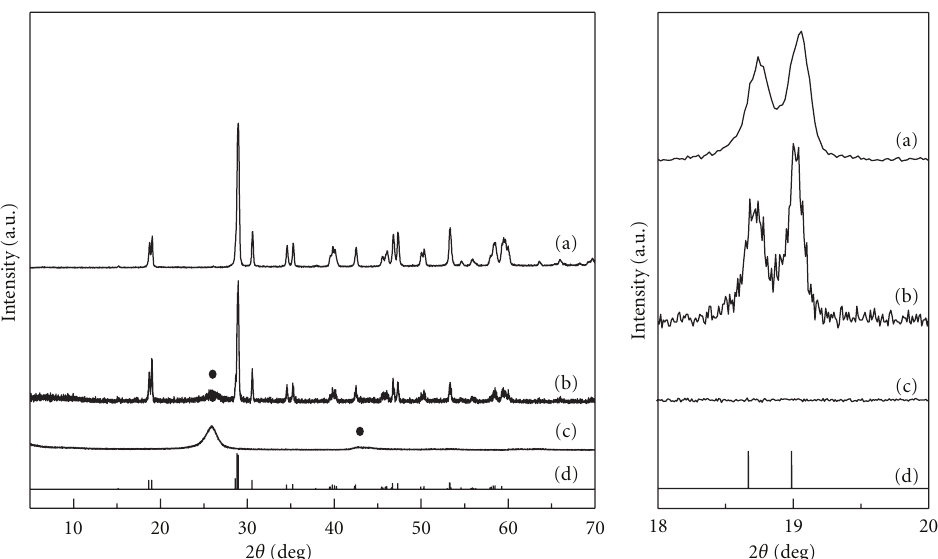
Figure 2: XRD patterns of (a) pure BiVO 4 nanoparticles, (b) BiVO 4 @MWCNTs nanoparticles, (c) MWCNTs, and (d) JCPDS card no. 14-0688.